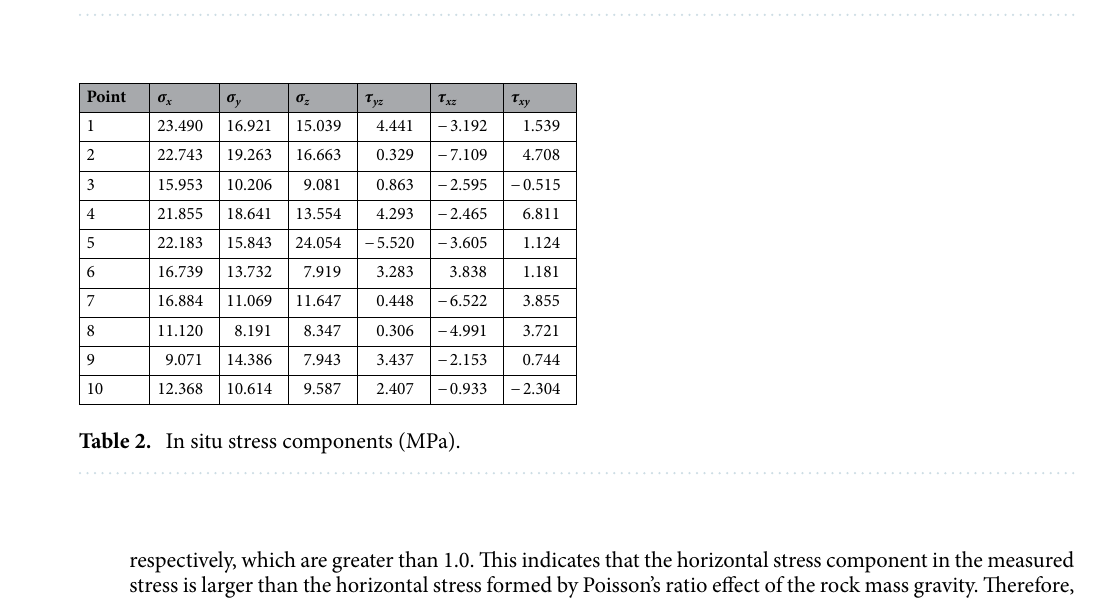
Table 1. In situ stress parameters measured. Positive normal stress indicates compression and negative normal stress indicates tension.